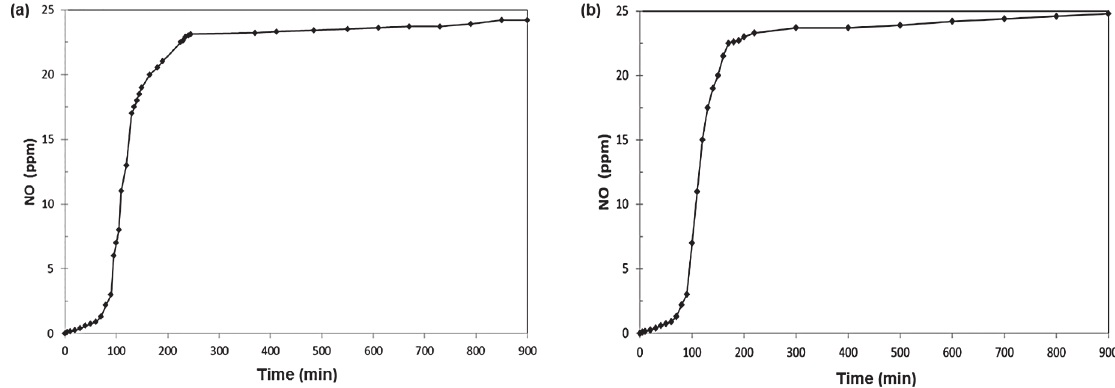
Figure 10 - Evolution of NO adsorption of samples (a) AVF 6 and (b) AVF 9.